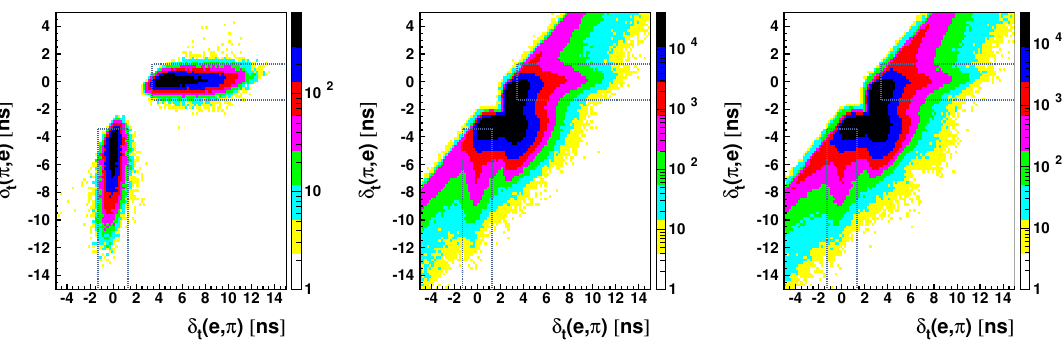
Figure 2 . Distribution of TOF di(cid:11)erences (cid:14) t ( (cid:25); e ) vs. (cid:14) t ( e; (cid:25) ) for simulated K S ! (cid:25)e(cid:23) events (left plot), all simulated events (center plot) and data (right plot). The signal events are se- lected in the regions delimited by the dashed lines: ( j (cid:14) t ( e; (cid:25) ) j < 1 : 3 ns ; (cid:14) t ( (cid:25); e ) < (cid:0) 3 : 4 ns)